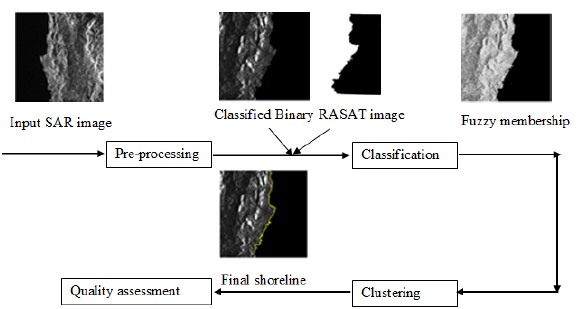
Figure 4. Flow chart of the shoreline detection from SAR image